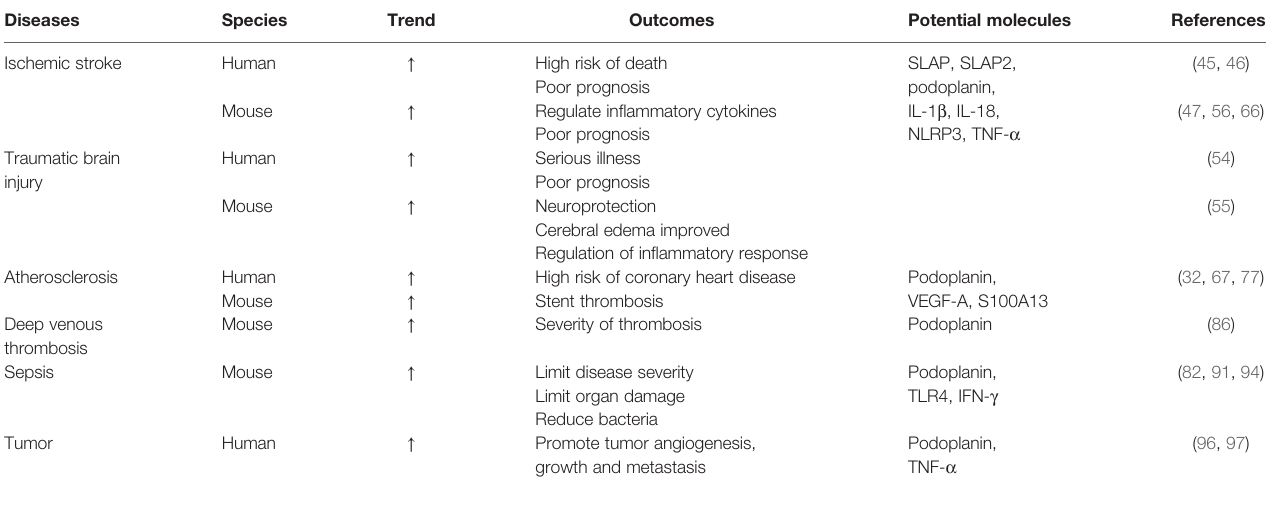
TABLE 1 | CLEC-2 in thromboin fl